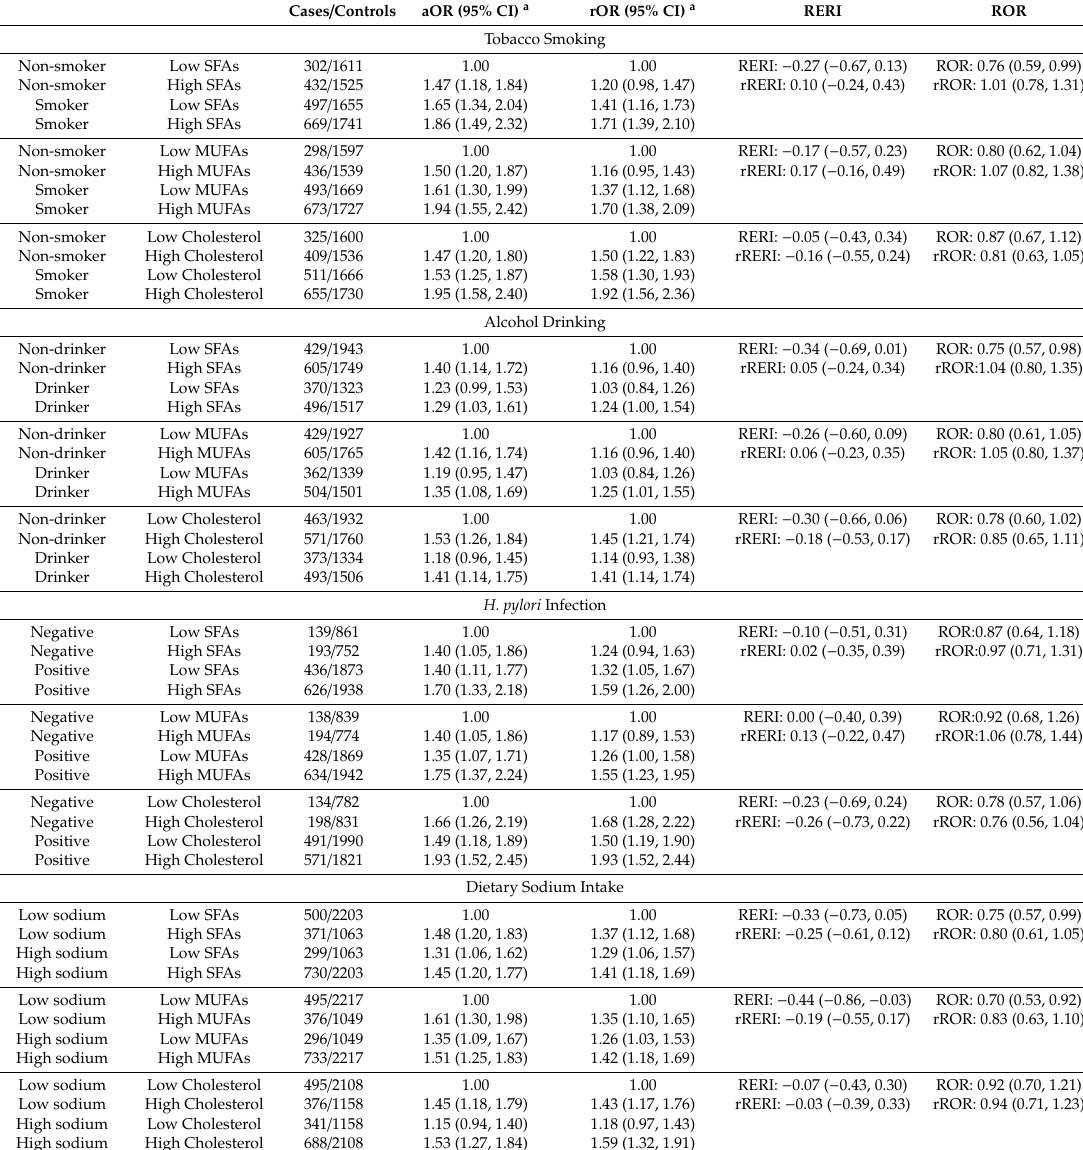
Table 4. The interactions between dietary intakes of saturated, monounsaturated fatty acids, and total cholesterol and main risk factors on stomach